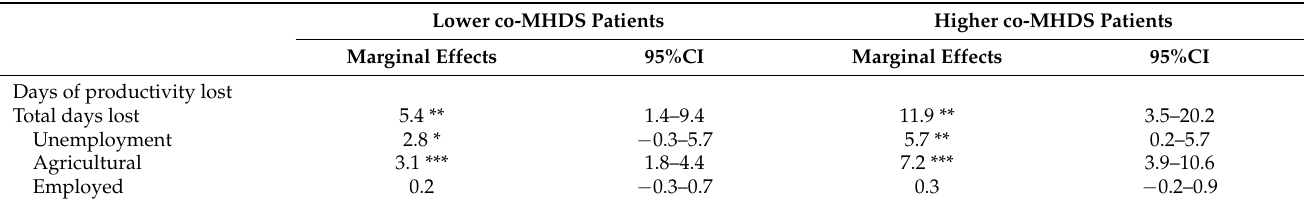
Table 3. Additional productivity days and economic loss of depressive symptoms among middle-aged and elderly people with